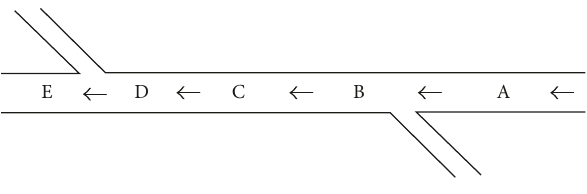
Figure 1: Location of 5 adjacent points in one